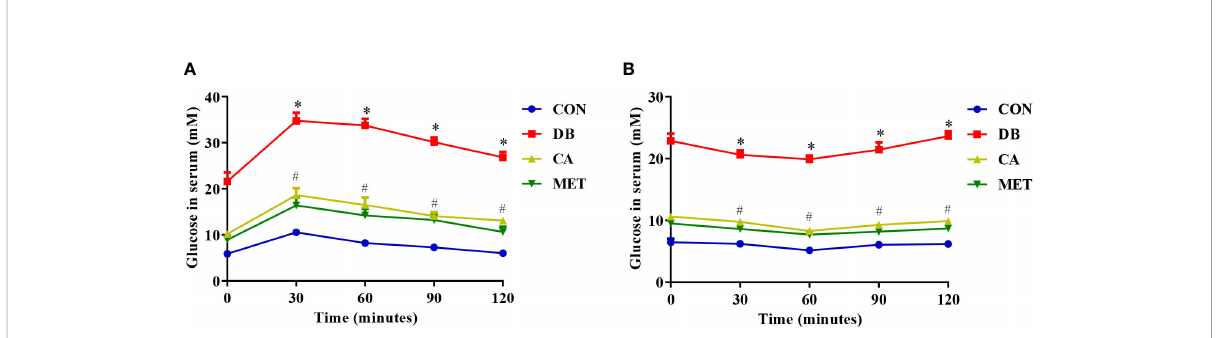
FIGURE 1 Effects of chlorogenic acid on glucose tolerance and insulin resistance in diabetic db/db mice. (A) Glucose tolerance; (B) Insulin resistance. Data are expressed as the means ± SEMs, n=6. * P < 0.05 (signi fi cant difference between mice in the DB group and mice in the other groups); # P < 0.05 (signi fi cant difference between mice in the CON group and mice in the CA and MET groups).